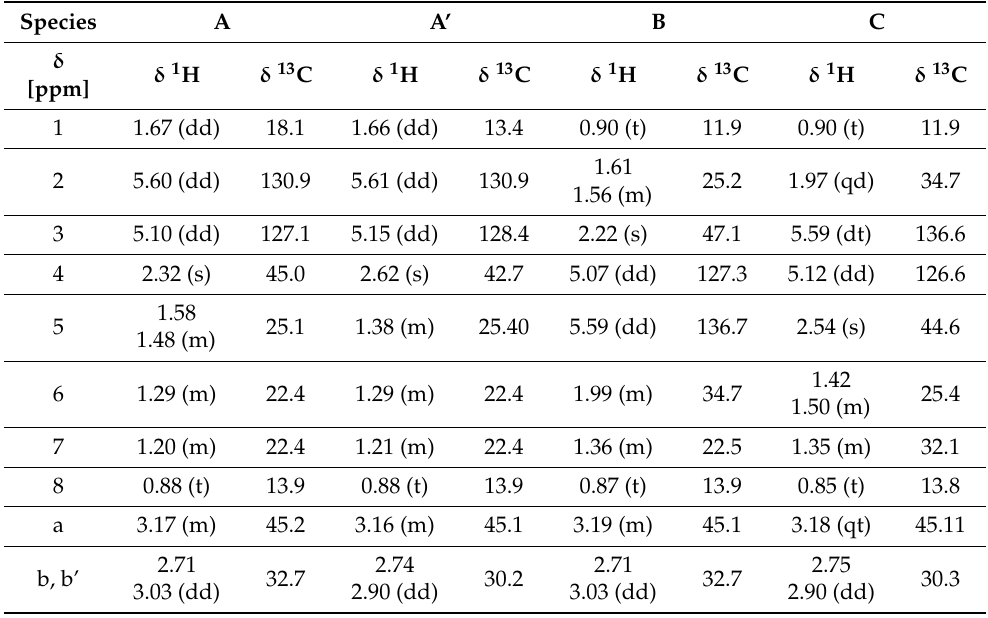
Table 1. Chemical shifts (multiplicity) of trans-3-octene’s products according to the labeling of Scheme 4. d = doublet, t = triplet, m = multiplet, s = septet, dd = doublet of doublets, qd = quartet of doublets, dt = doublet of triplets, qt = quintet. Species A A’ B C δ δ 1 H δ 13 [ppm]